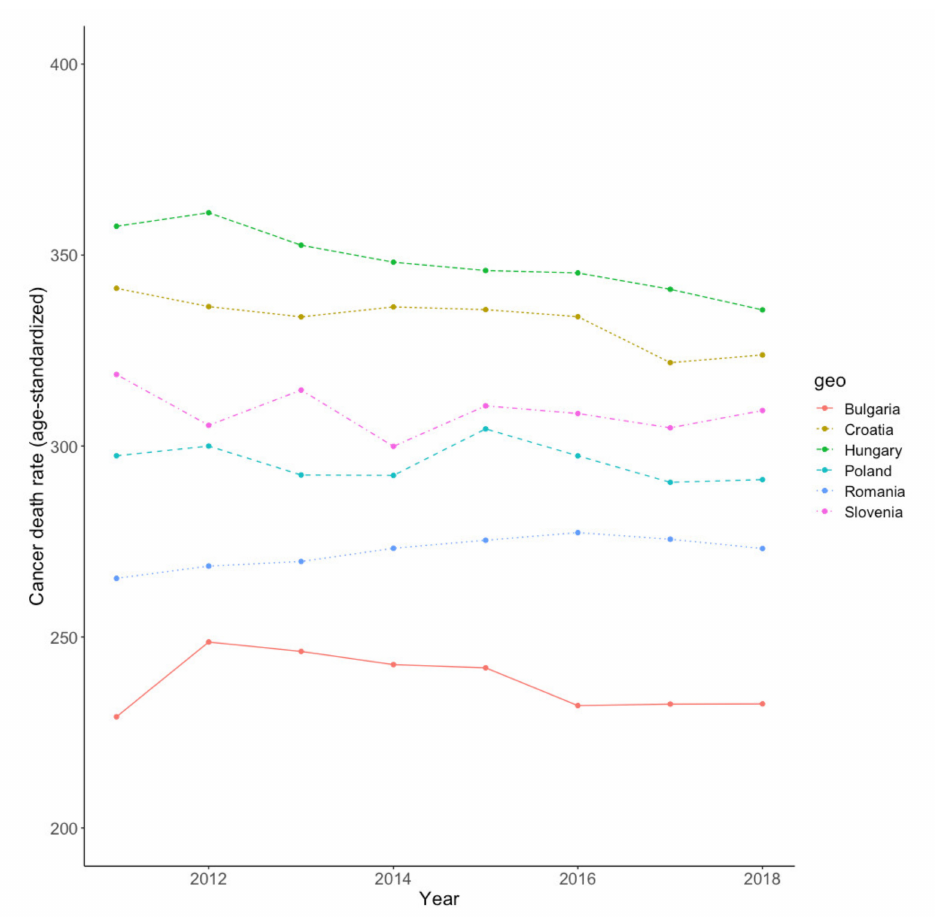
Figure 3. Trends in cancer mortality rates in selected CEE countries (2011–2018). Estimation results. Plot created in R software (“ggplots” function). Source of data: Eurostat.